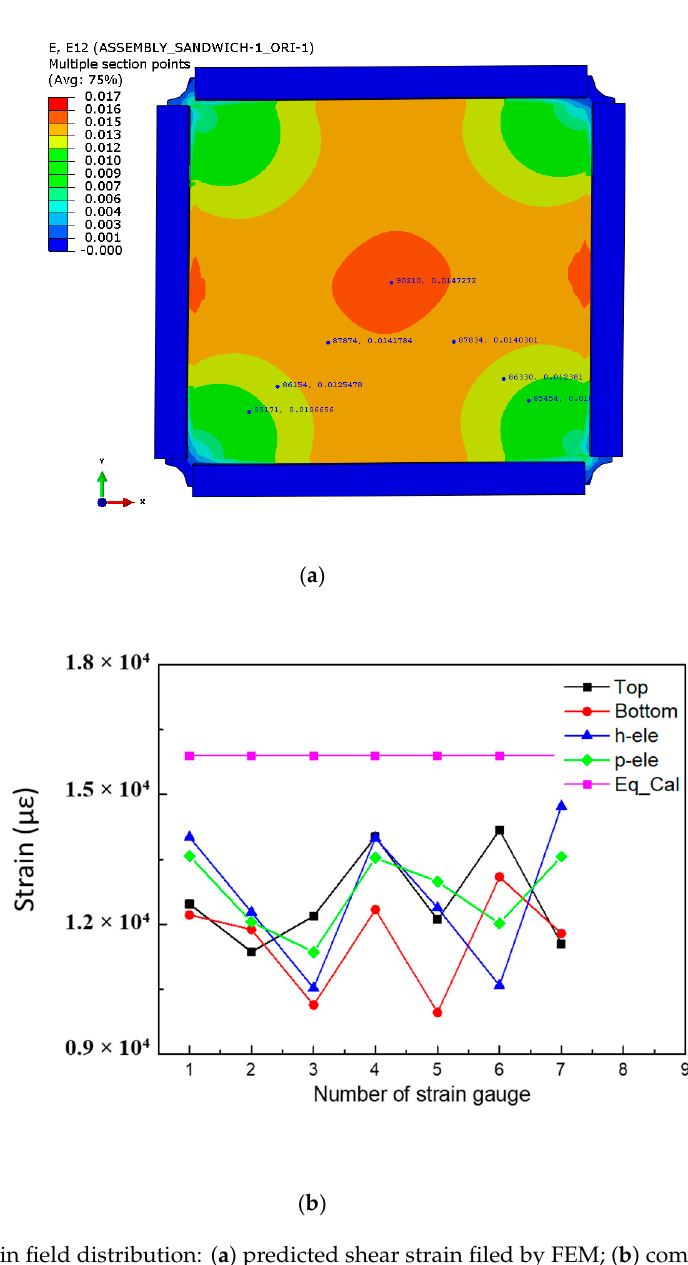
Figure 20. Strain field distribution: ( a ) predicted shear strain filed by FEM; ( b ) comparison of shear strain filed obtained by experimental and predicted methods.